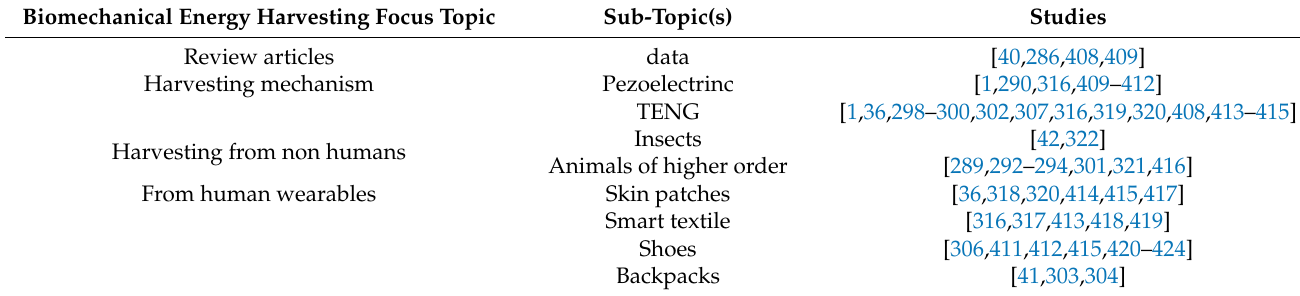
Table 3. Summary of reviewed works on biomechanical energy